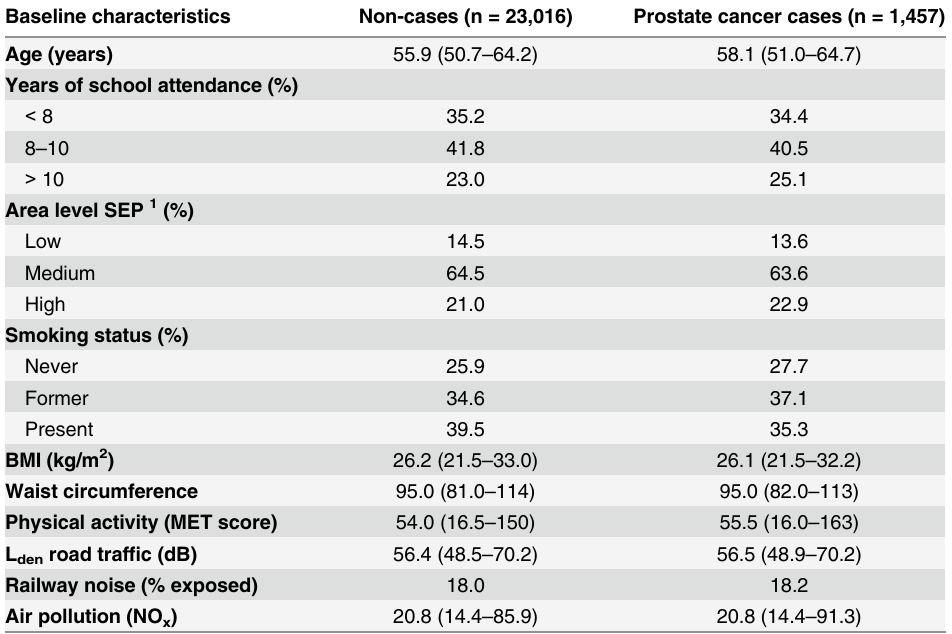
Table 1. Baseline characteristics of the 24,473 male participants in the Diet, Cancer and Health cohort by prostate cancer